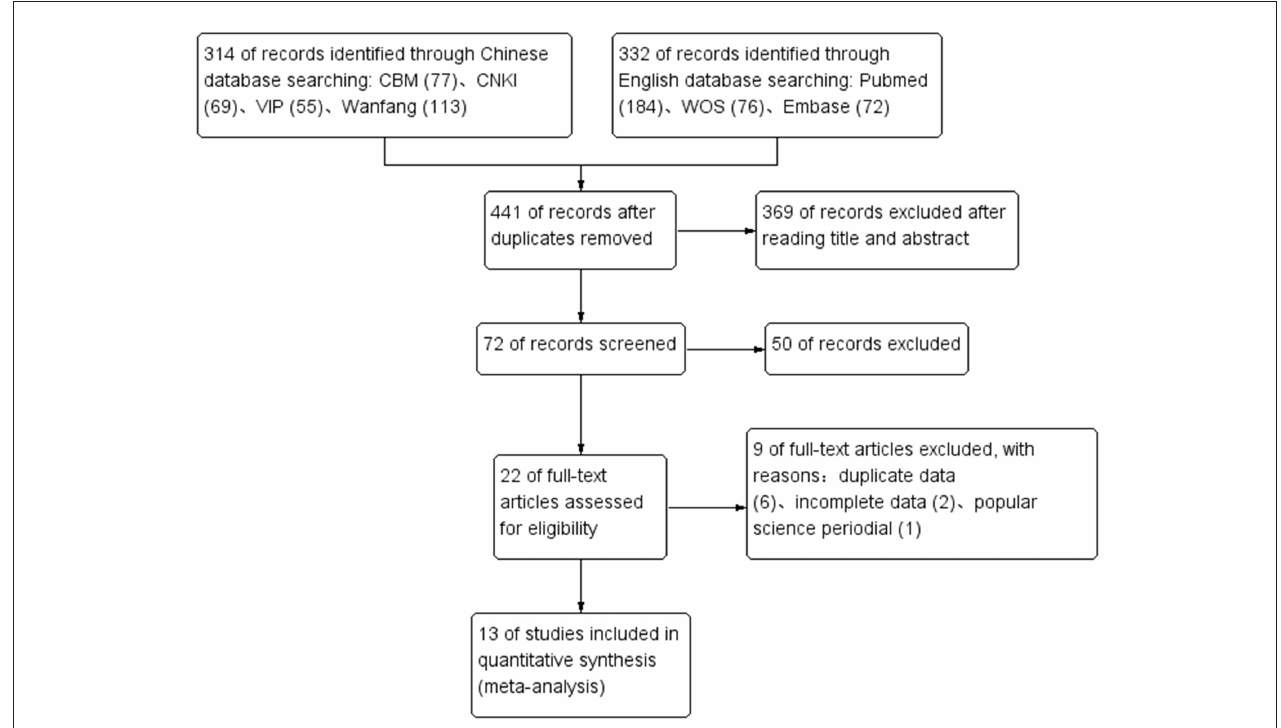
FIGURE 1 | Flow diagram for the process of searching and